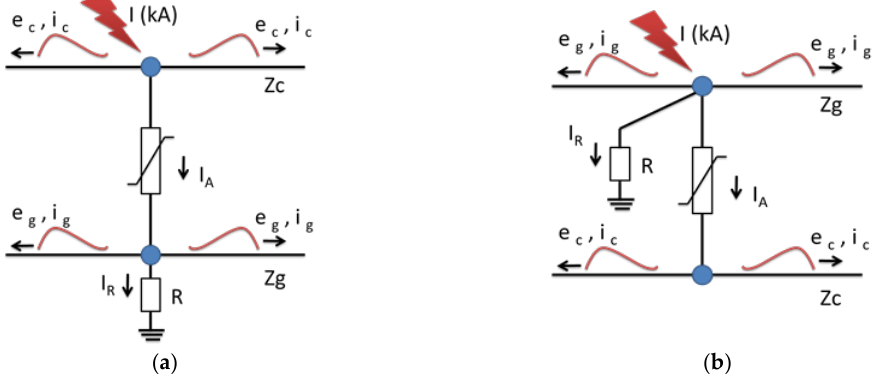
Figure 18. Result of a lightning strike to the phase conductor and overhead ground wire when an arrester is installed; ( a ) Strike to the phase conductor; ( b ) Strike to the overhead ground wire.